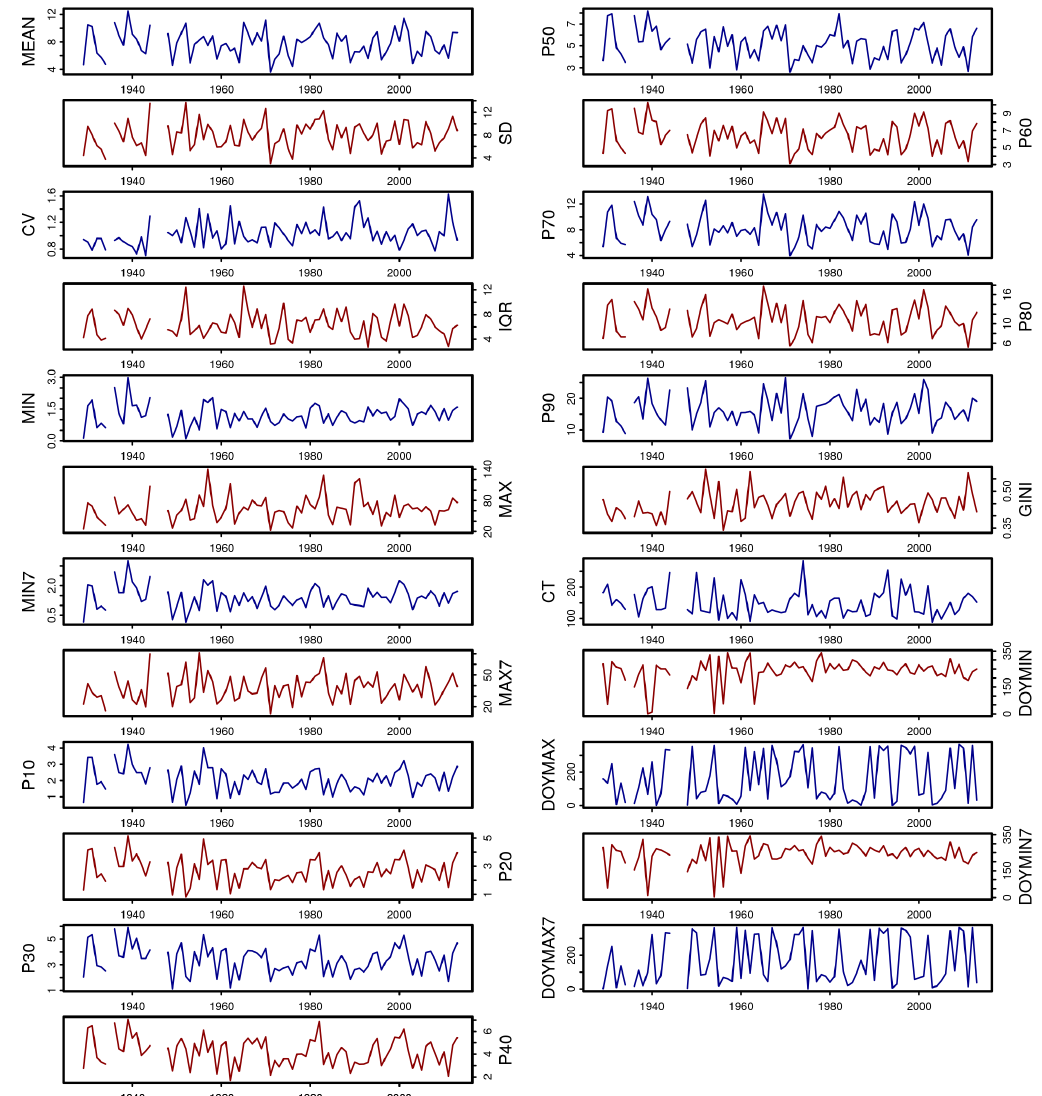
Figure 2. All considered indices at yearly resolution, shown for the River Wiese at Zell, south-western Germany. Yearly values are only displayed if they contain at least 350 reliable daily observations. See the text for details on units, interpretation and reliability